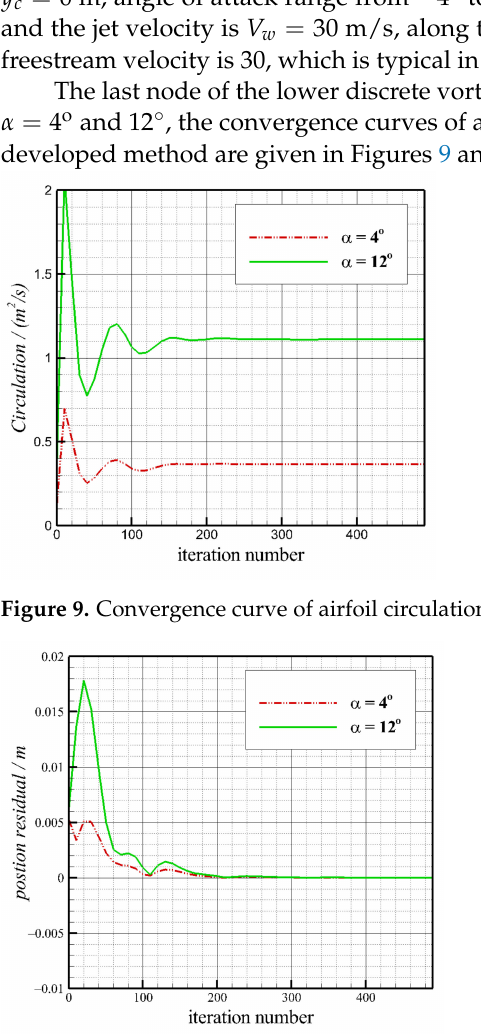
Figure 10. Residual curve of the jet boundary